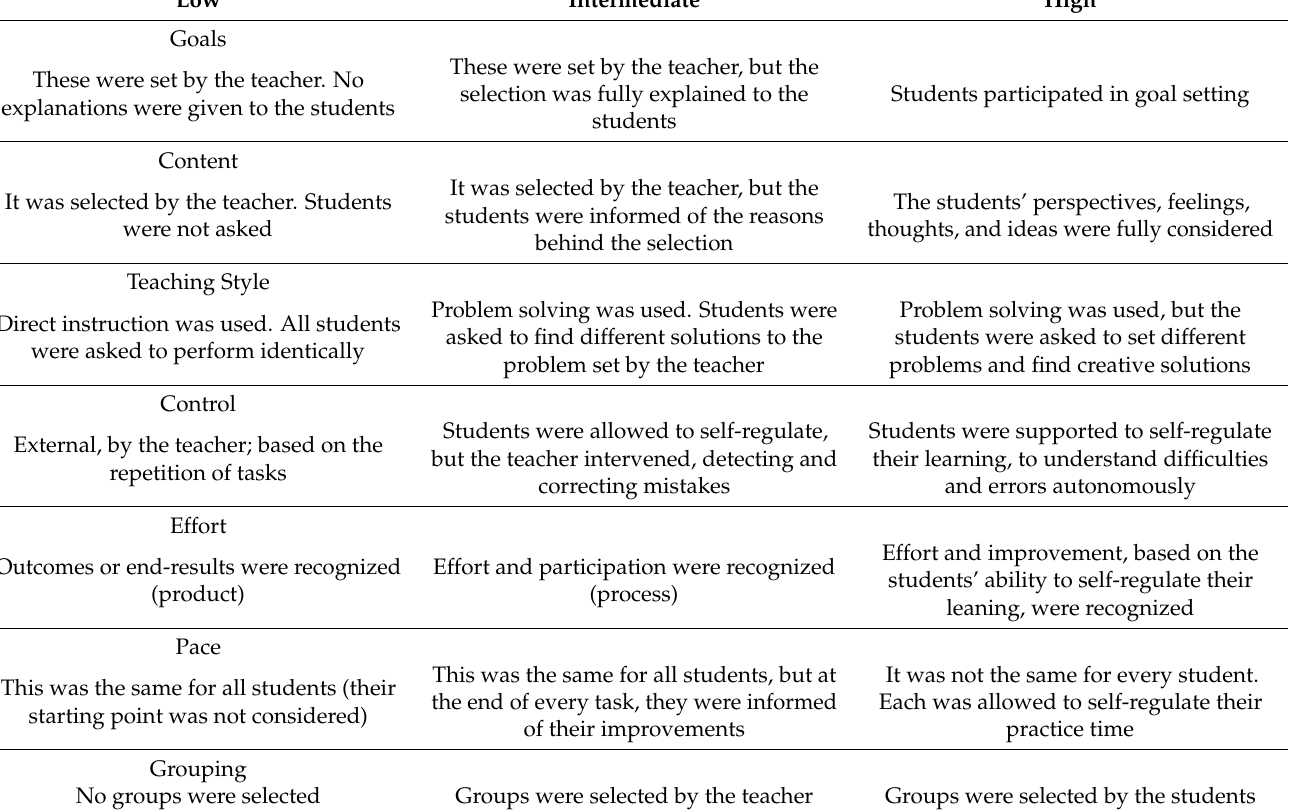
Table 1. Teacher’s autonomy support in session one, two, and